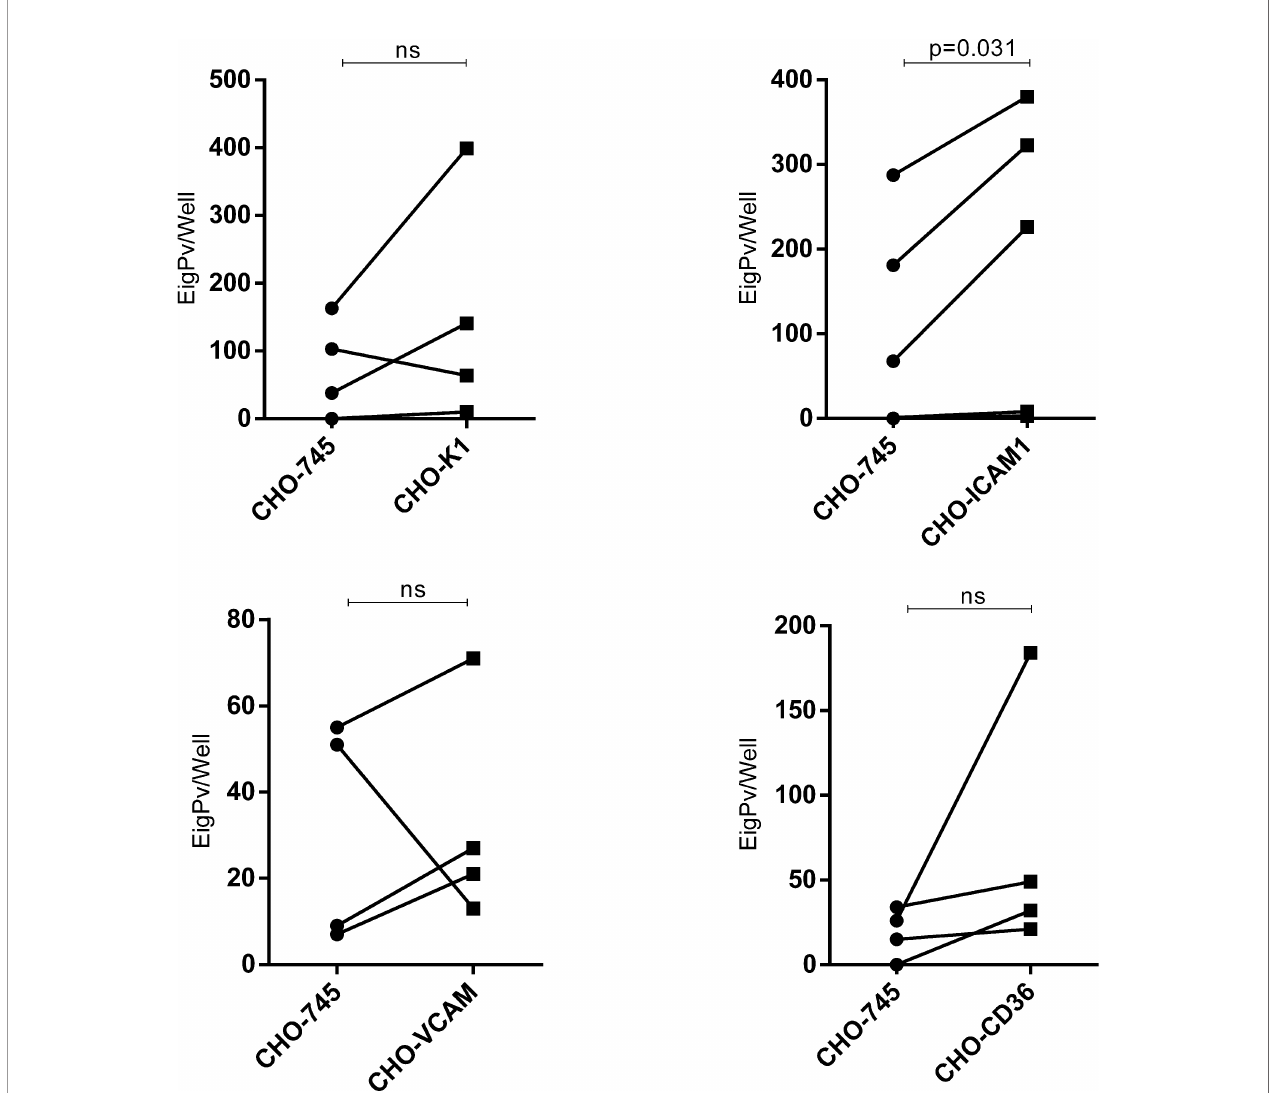
FIGURE 3 | Comparison between adhesive capacities of Plasmodium vivax gametocytes to different endothelial receptors. Adhesion ability to different endothelial receptors of Plasmodium vivax gametocytes from one isolate was compared to its ability to adhere to the control cell (CHO-745). Cytoadhesion was expressed as total gPv-pRBC adhered to CHO cells per well. The gametocytes adhered per well from each isolate are presented as a circle (adhesion to CHO-745) or square (adhesion to transfected CHO) and linked by a line. The data was analyzed for Wilcoxon signed-rank test (P<0.05). ns, not signi fi